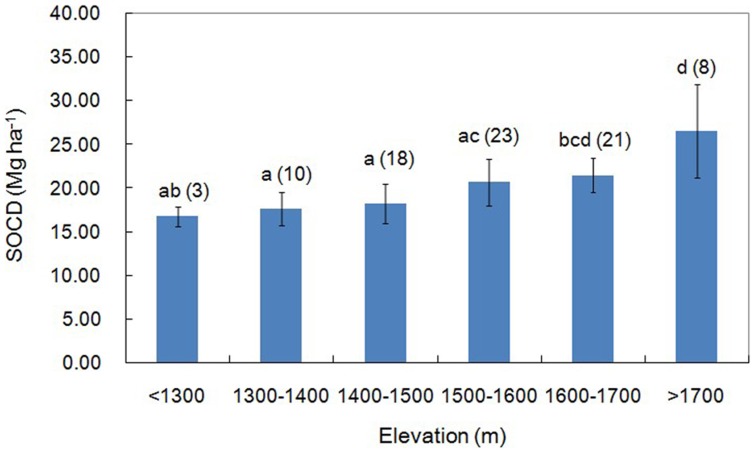
Relationship of elevation and topsoil SOCD.* The error bars are the standard errors of the mean of SOCD and values above the bars is the number of observations (in parentheses). A different letter means a difference significant at P<0.05.